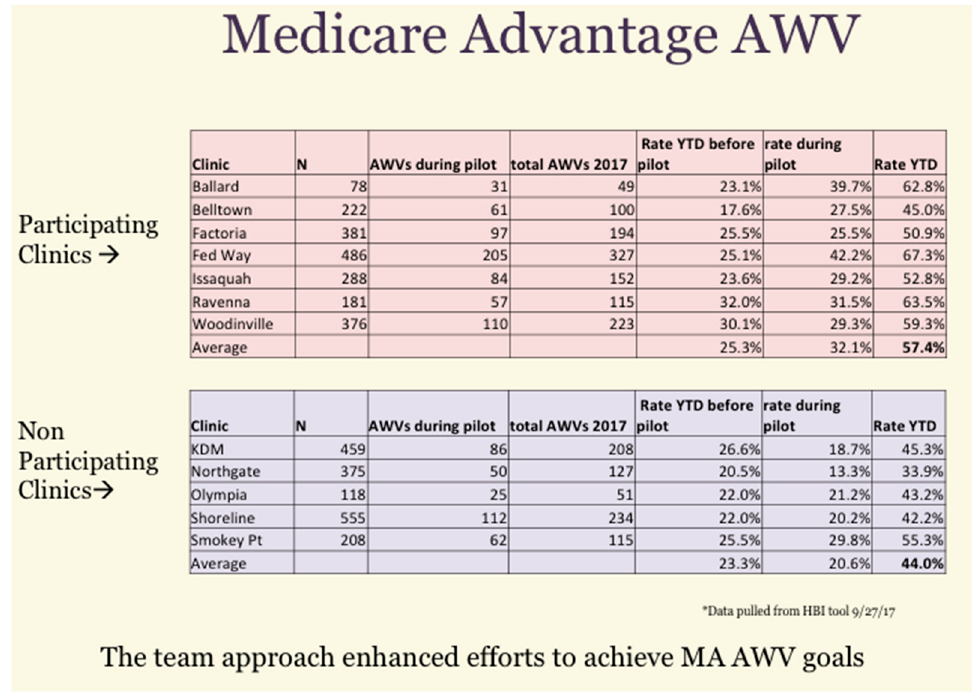
Figure 4. Cumulative results of a Medicare Annual Wellness Visit (AWV) initiative showing year-to- date (YTD) improvements. year-to-date (YTD)